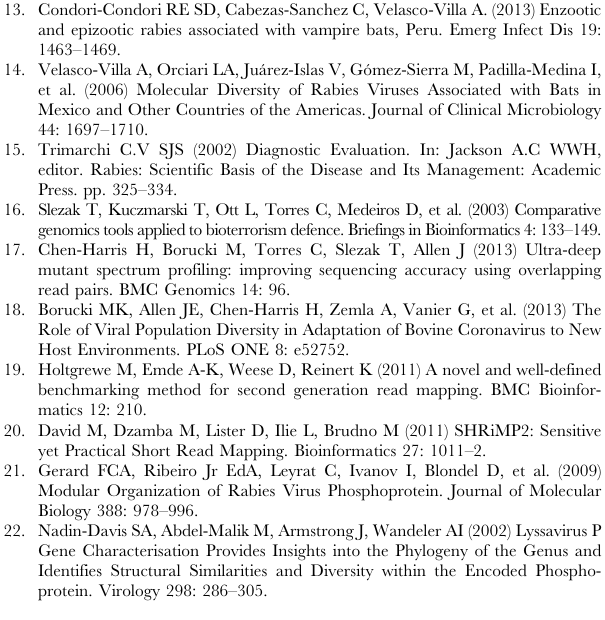
Figure S6 Phylogram constructed from L gene amino acid sequence. The evolutionary history was inferred by using the Maximum Likelihood method as described for Fig. S3. The tree with the highest log likelihood (-3901.1361) is shown. The analysis involved 38 amino acid sequences. The coding data was translated assuming a Standard genetic code table. All positions with less than 95% site coverage were eliminated. There were a total of 1322 positions in the final dataset. Evolutionary analyses were conducted in MEGA5. Figure S7 Phylogram generated using nucleotide se- quences from the noncoding regions. The evolutionary history was inferred by using the Maximum Likelihood method as described for Figure 1. The analysis involved 43 nucleotide sequences. All positions with less than 95% site coverage were eliminated. There were a total of 862 positions in the final dataset. Samples and regions are labeled as previously described. Figure S8 Distribution of nonsense mutations. Abscissa: genome positions and gene locations of the stop codon mutations. Ordinate: sample ID. Colorbar indicates frequency of the mutations in logarithm scale. Figure S9 Genomic distribution of rabies variants found by Illumina sequencing. Not all rare variants were included for this graph, only those variants (N =248) that occurred at above 1% in an individual sample or have a cumulative frequency of . 1% over all samples were displayed here. Colorbar on the right indicates the frequency of these rare variants. Variants